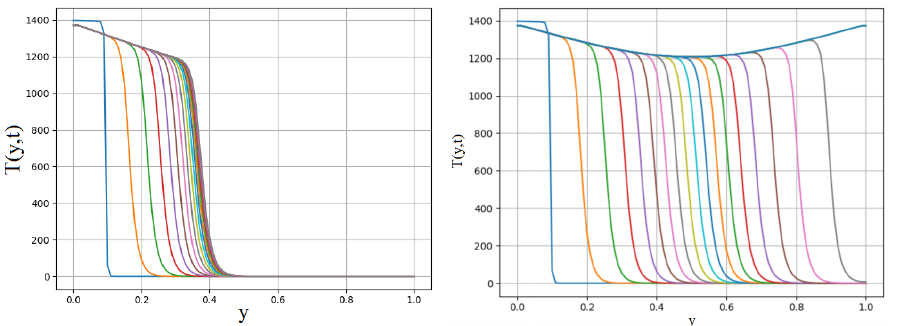
Figure 2. Solution of Equation (1) with function Φ ( T , y ) , where u ( y ) = y ( H − y ) , and H is the height of the vessel. The thrombin wave propagates from left to right; each curve shows the distribution of the thrombin concentration in the space for a fixed time (each 40 min). It propagates until the flow velocity becomes sufficiently large enough to stop it ( left ). If the maximal flow velocity at the center of the vessel is not sufficient to stop it, then it propagates till the end of the interval ( right ). The thrombin concentration decreases at the center because of the larger flow velocity. The values of parameters are given in Table 1, α = 0.5 for the left image and α = 0.4 for the right image, H = 1